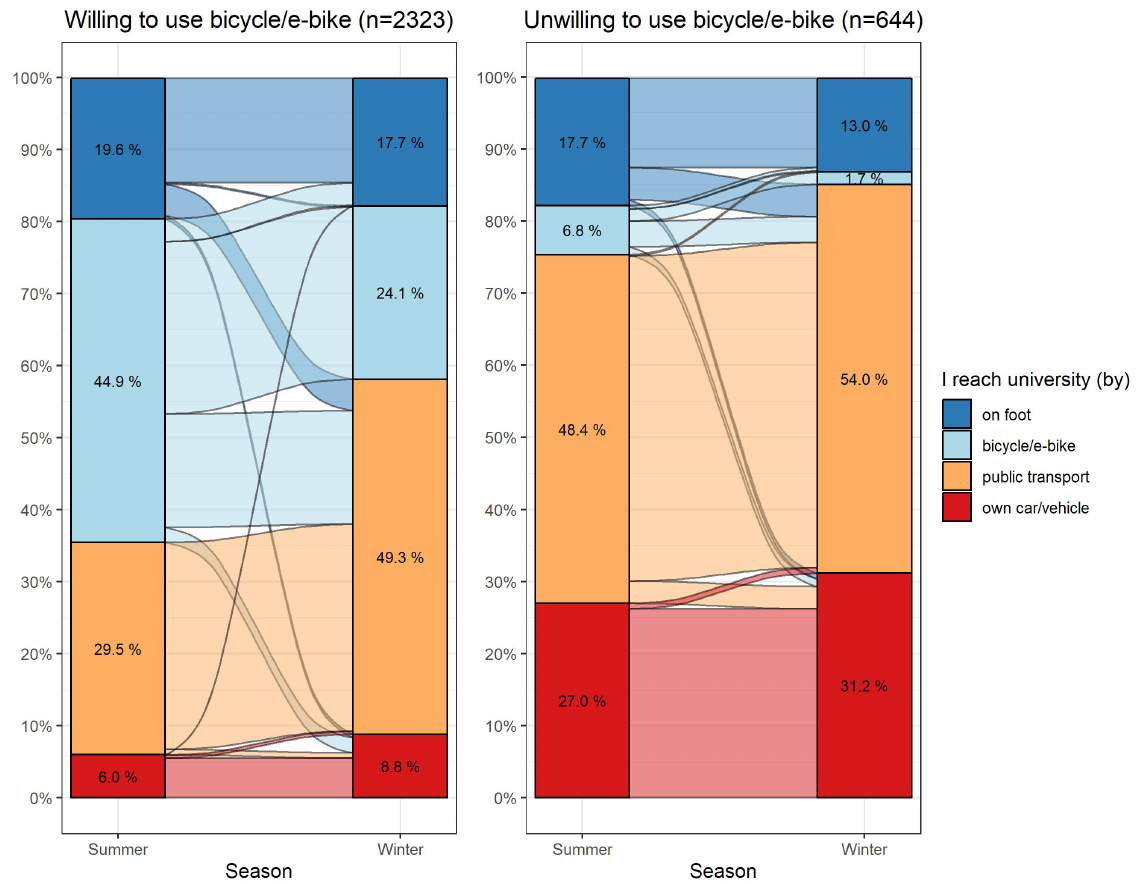
Figure 2. Means of transport commuting to and from the university in the summer and the winter, stratified by willingness to use a bicycle/e-bike ( n = 2967). The curves between the bar charts represent changes in the composition of the strata between summer and winter.